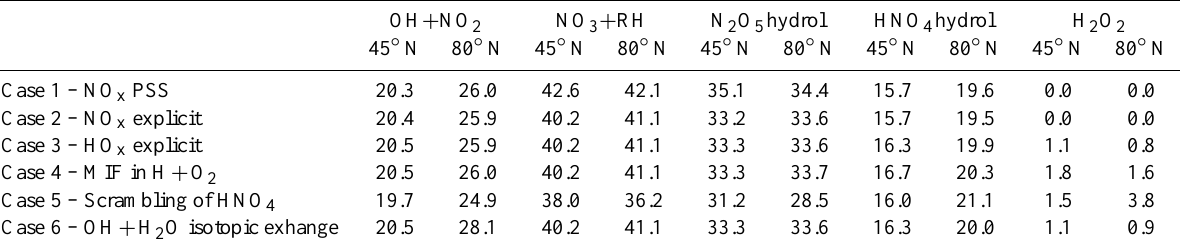
Table 7. Comparison of diurnally-integrated source isotopic signature (DIIS, in ‰ units) for the four nitrate and H 2 O 2 production channels considered under mid-latitude (45 ◦ N, 293K) and Arctic (80 ◦ N, 253K) conditions in springtime (1